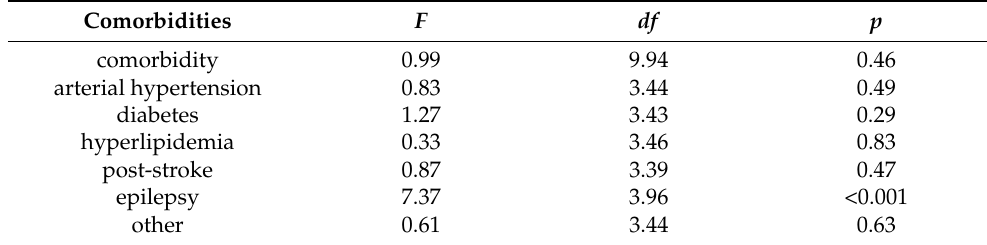
Table 3. The interaction effect of comorbidity on BPRS